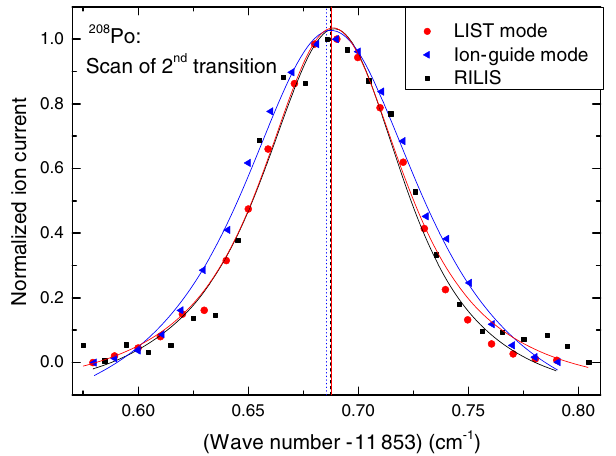
FIG. 8. Resonance line profile of the transition at 843.4 nm in 208 Po recorded using Faraday-cup detection for both operation modes of the LIST (FWHM ∼ 2 . 5 GHz) and for a standard RILIS (FWHM ∼ 2 . 2 GHz). The lines along the data points represent the best fits to the data [38]. The vertical lines highlight the centroids extracted from these